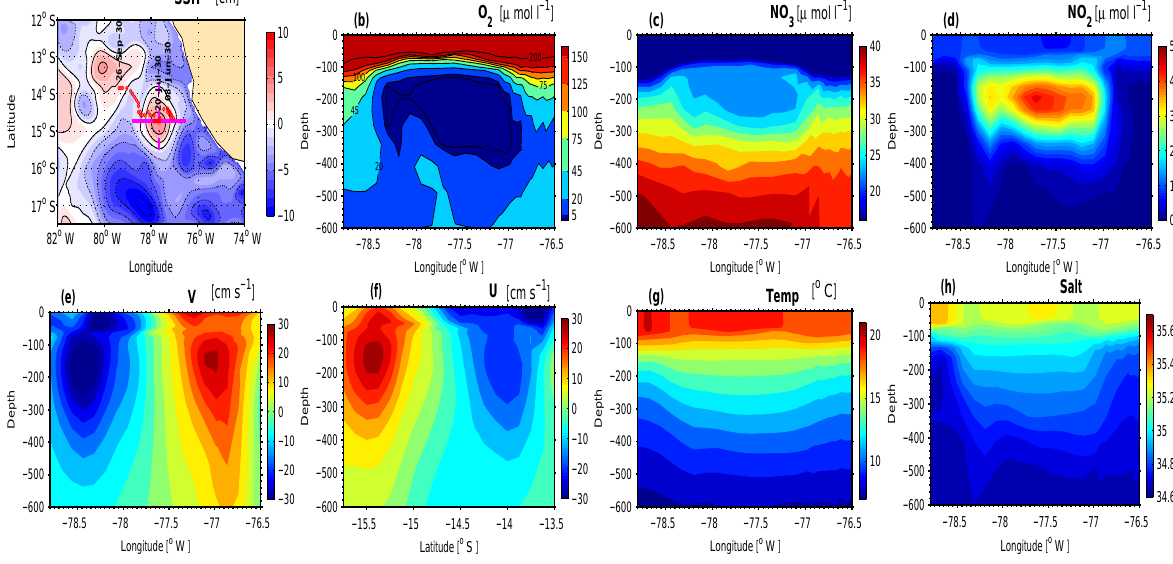
Figure 4. (a) Sea surface height (cm), (b) oxygen (µmolL − 1 ), (c) nitrate (µmolL − 1 ), (d) nitrite (µmolL − 1 ) concentrations, (e) meridional velocities (cms − 1 ), (f) zonal velocities (cms − 1 ), (g) temperature ( ◦ C) and (h) salinity across the eddy A sim centre. Nitrate, oxygen, nitrite, temperature, salinity and meridional velocity section around 14.75 ◦ S (magenta full line in a ). Section for zonal velocity around 77.65 ◦ W (magenta dashed line in a ). This dynamic corresponds to 21 July model year 30. The temporal evolution of the eddy is indicated by the red